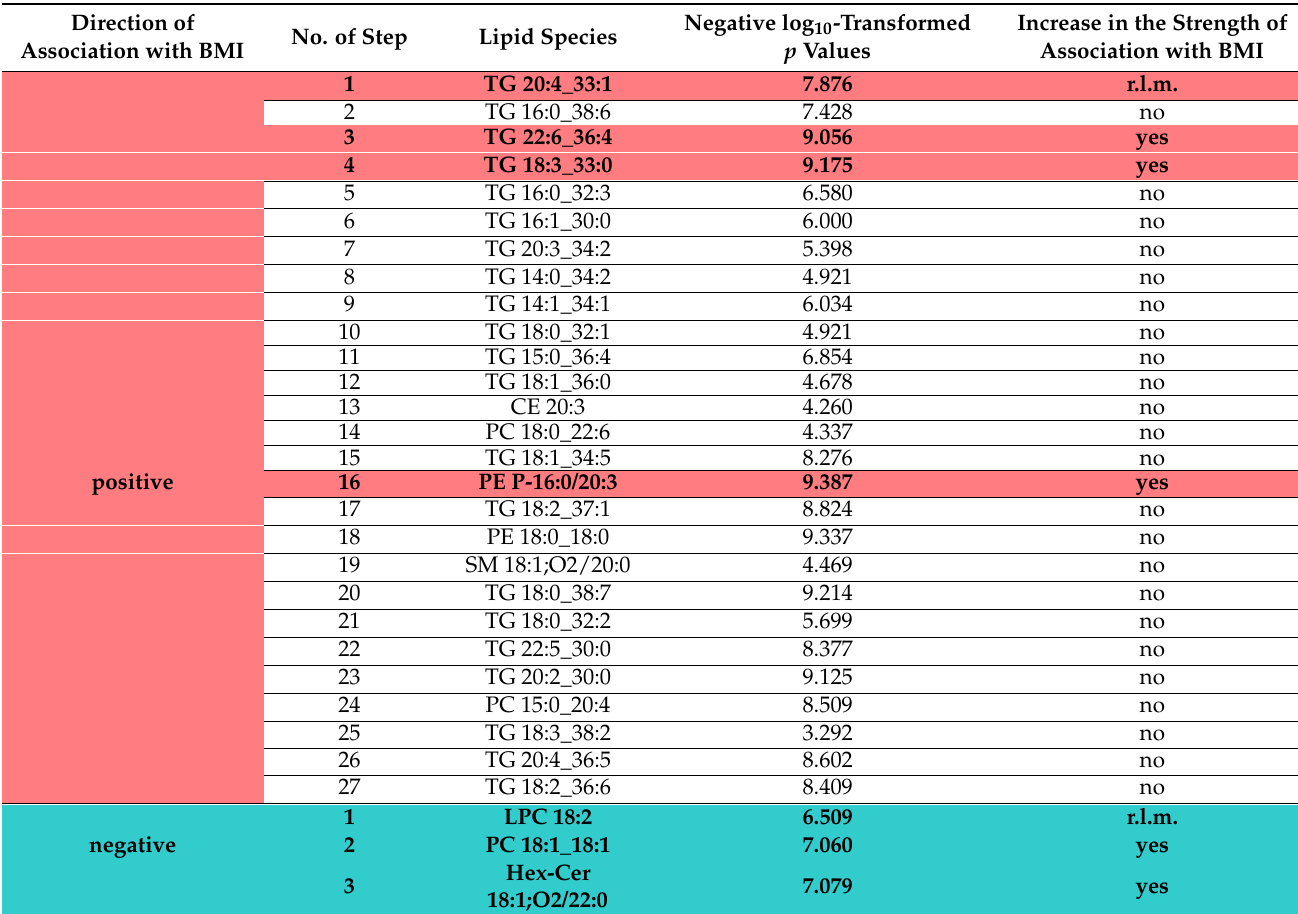
p values were obtained when considering the association between the sum of concentration of lipid species and BMI. The association was evaluated under adjusted (by sex, age, and ethnicity) regression models. A higher value of the negative log 10 -transformed p values indicates a stronger association between the sum of lipid species concentration and BMI. Red and green rows show lipid species showing a positive or negative association with body mass index (BMI) with a strength of association increasing effect, respectively. Abbreviations: CE = cholesterolester, HexCer = hexosylceramide, LPC = lysophosphatidylcholine, PC = phosphatidylcholine, PE = phosphatidylethanolamine, PE P = plasmenylethanolamine, SM = sphingomyelin, TG = triacylglycerol, r.l.m. = reference lipid